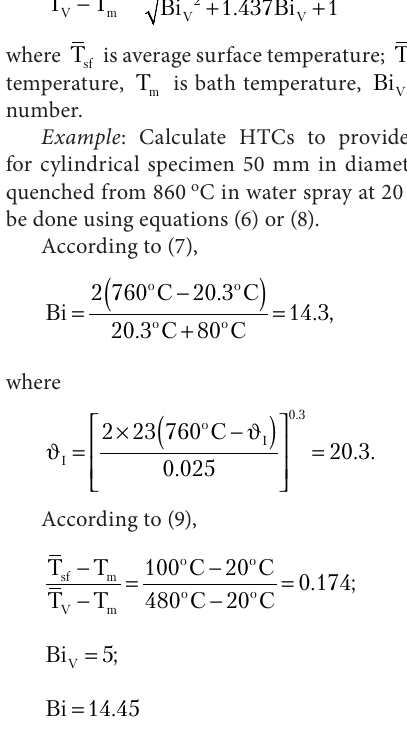
that practically is the same. It means that universal correlation can be used to predict direct convection for complicated con- figurations using (2) and (8). (2) is used to calculate absence of transient nucleate boiling